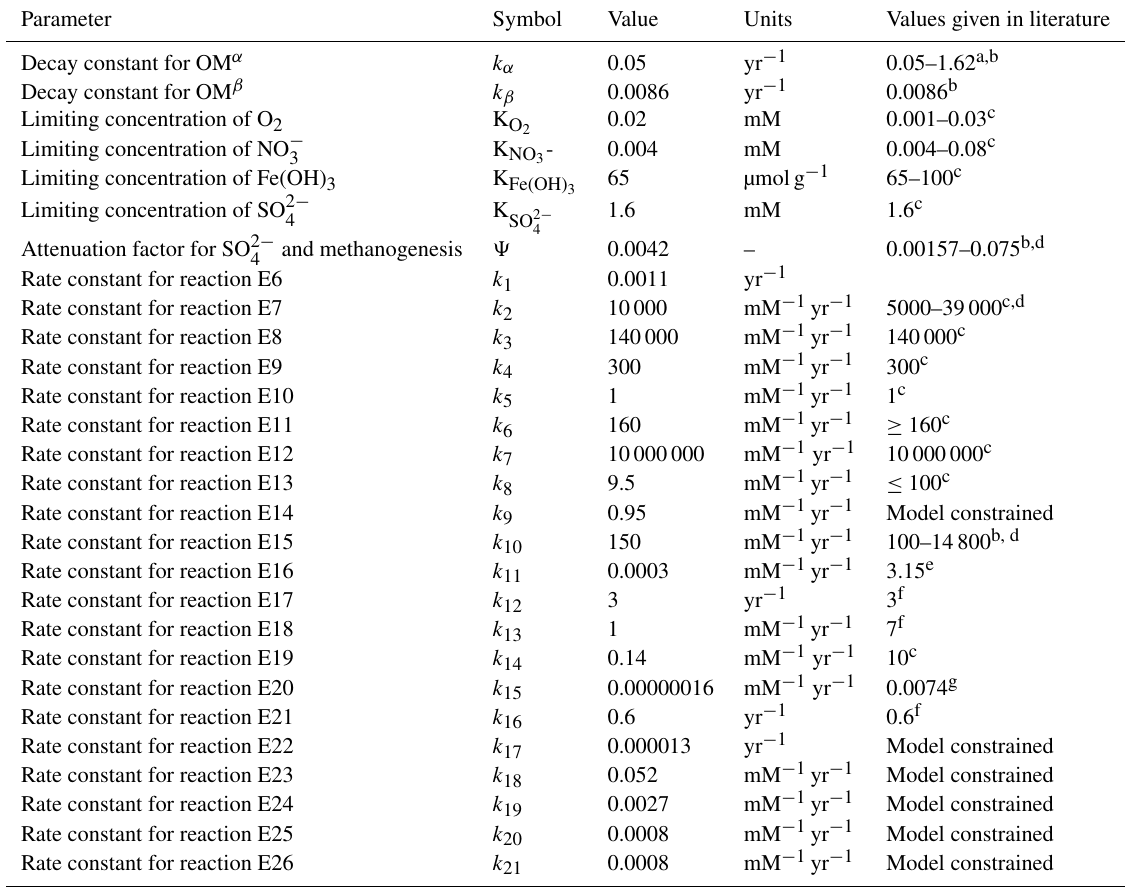
Table 5. Reaction parameters used in the diagenetic model.